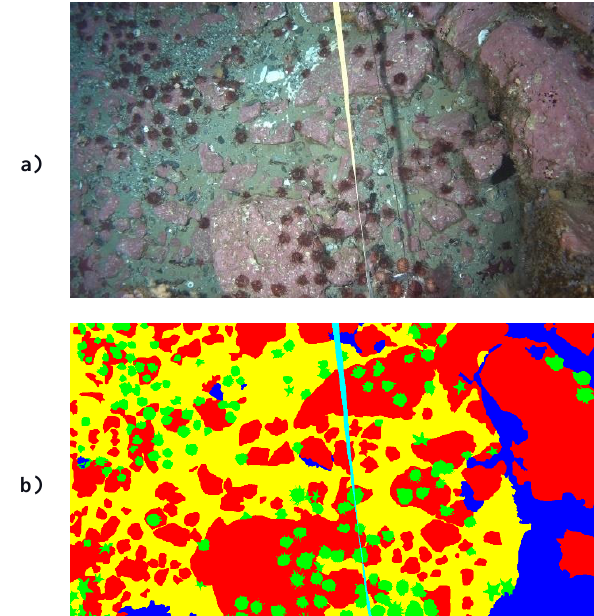
Figure 4. The original image (a) chosen for training and results of the testing used to evaluate the method (b). We divided it horizontally in 2 equal parts: the top part is used to create the training set and the other part (the bottom half) is used for testing.